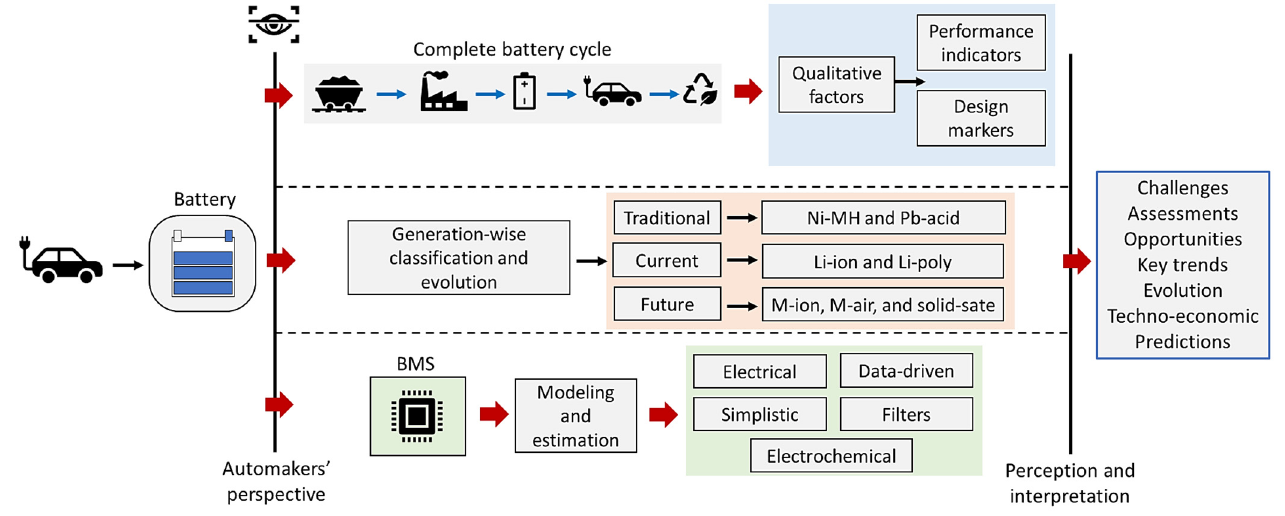
Figure 4. Contents and contributions of this article in a nutshell.